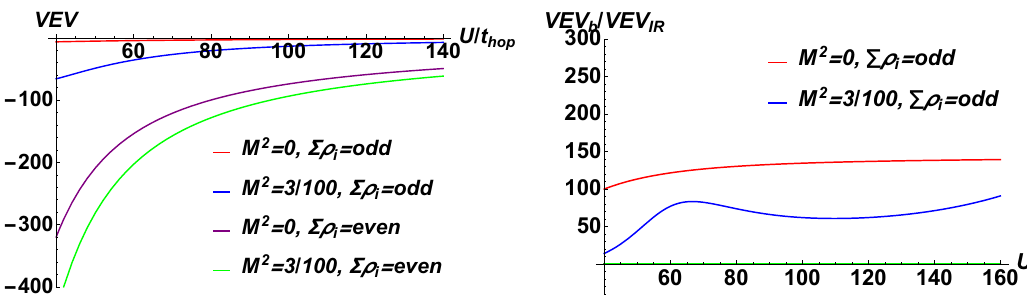
(cid:14)(cid:26) 1 j j(cid:20) (cid:14)(cid:26) 1 and varying M , the j j(cid:20)